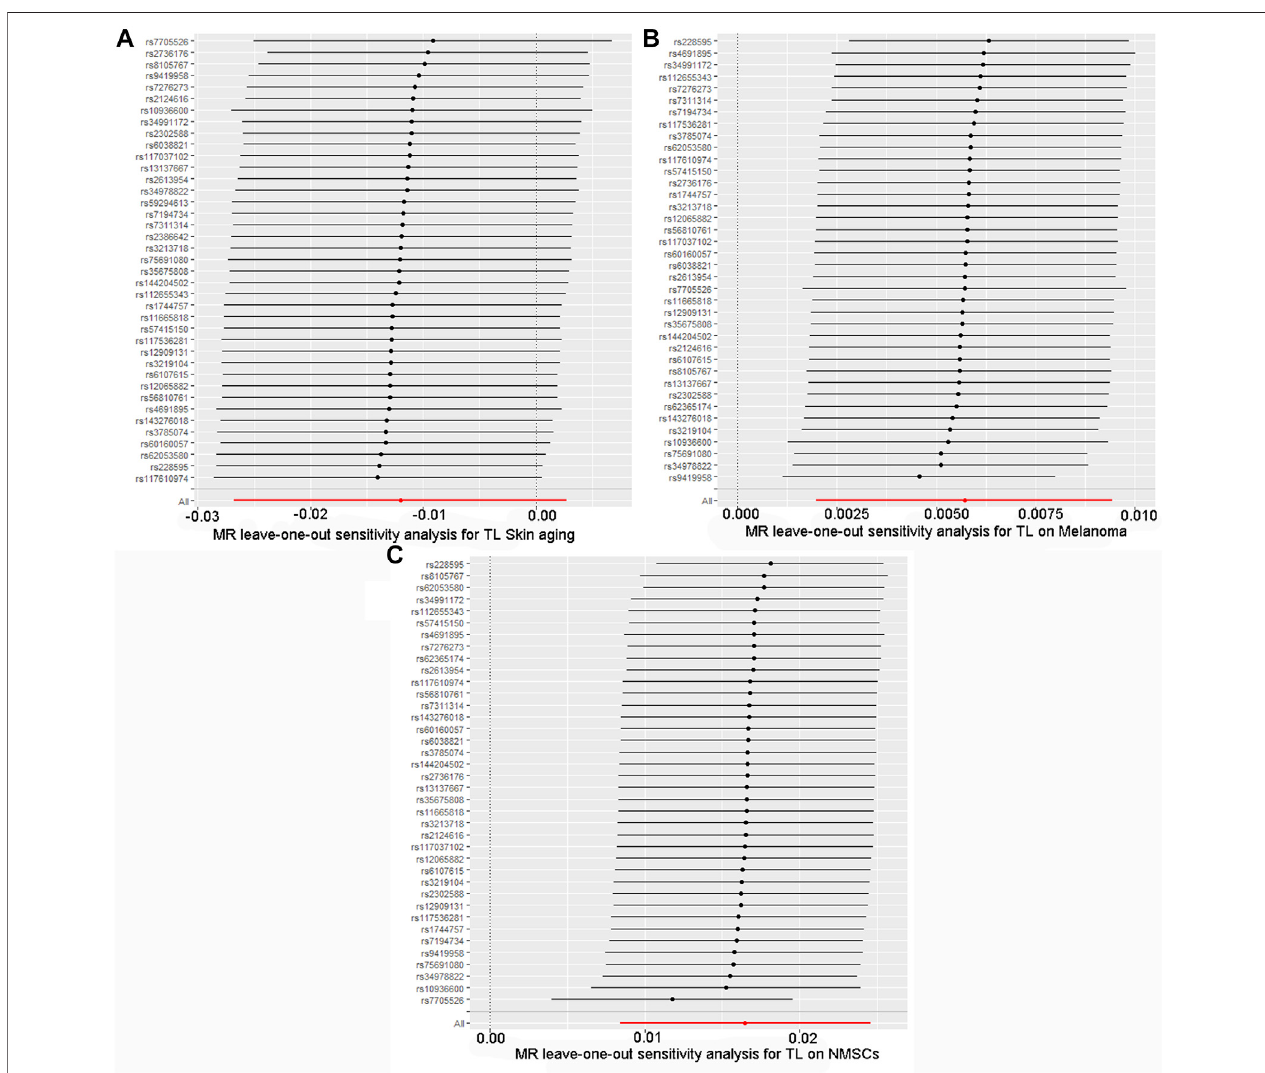
FIGURE 6 | Forest plot for leave-one-out sensitivity analysis. (A) Skin aging; (B) Melanoma; (C) NMSCs.Each horizontal solid line re fl ects the result estimated by a single SNP using the Wald ratio method.The solid line is completely to the left of 0, indicating that the estimated result from this SNP is that TL shortening can increase skinaging.Thesolidlineiscompletelytotherightof0,indicatingthattheestimated resultfromthisSNPisthatTLshorteningcanreducetheriskofskincancer.AllSNPs are on the side of 0, representing the stabilityof the results.